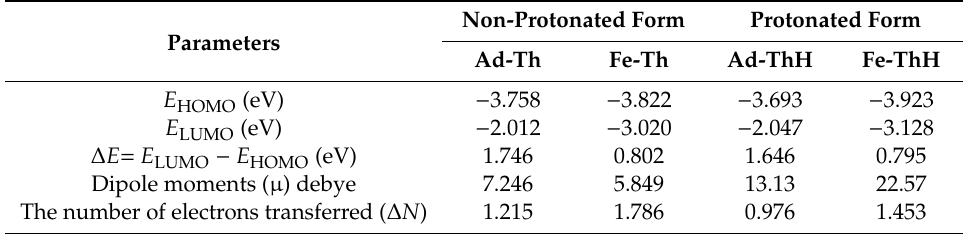
Table 3. DFT parameters of the non-protonated and protonated Ad-Th and Fe-Th molecules.